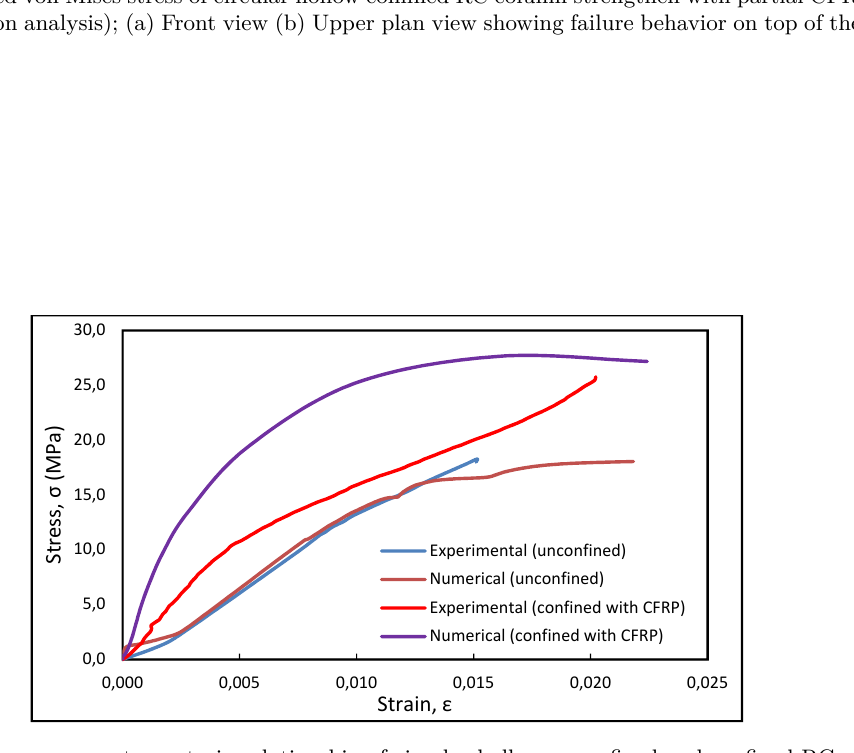
Figure 9. Validation process stress-strain relationship of circular hollow unconfined and confined RC column with CFRP under full axial